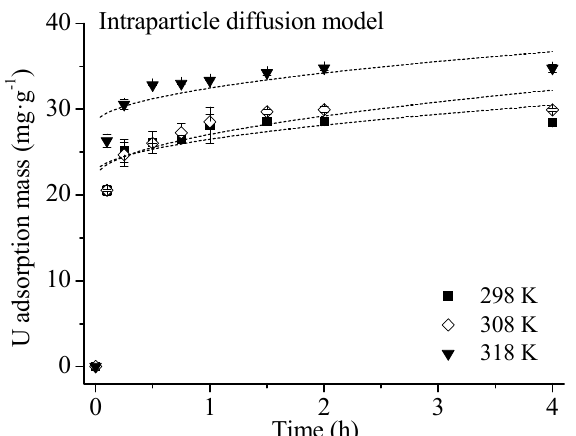
Figure 3. Intraparticle di ff usion model for U(VI) adsorption onto HA at di ff erent temperatures. Experimental conditions: adsorbent mass: 20 mg; solution volume: 30 mL; U(VI) concentration: 60 mg / L; contact time: 0.1, 0.25, 0.5, 0.75, 1, 1.5, 2 and 4 h; initial pH = 3.0; end pH: 2.70–2.90. Table 3. Intraparticle diffusion coefficients and intercept values for U(VI) adsorption on HA particles at different temperatures.